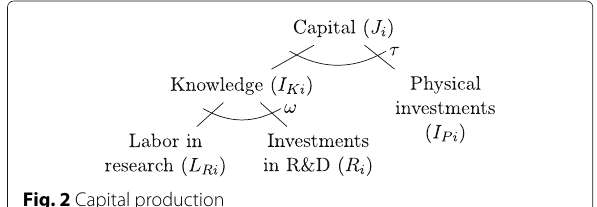
Fig. 2 Capital production